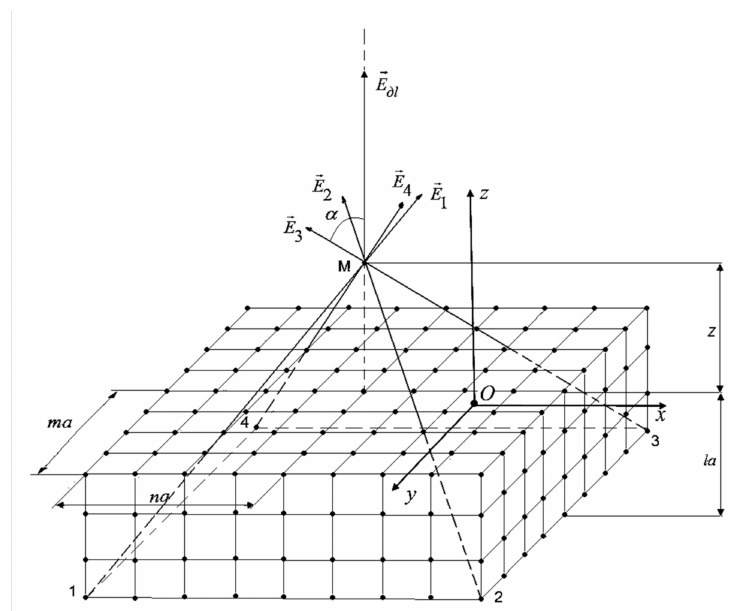
Figure 4. Layer model with intermittent charge distribution. Explanatorily depicts several vectors and their resultant electric field strength at a point located on one normal with the charge. n , l , and m are